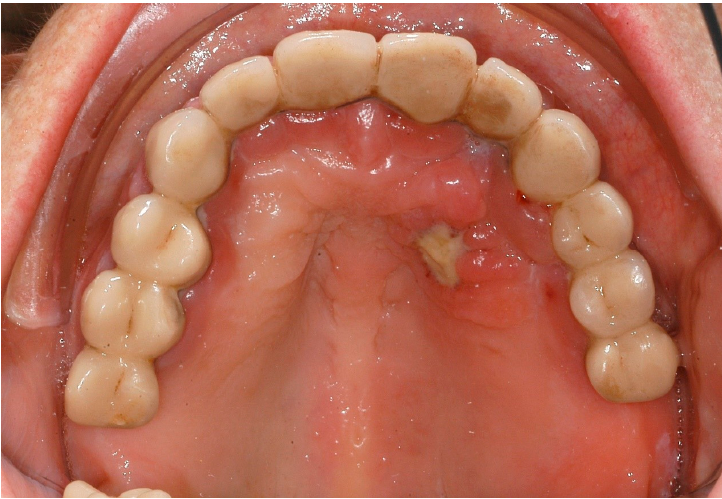
Figure 5. Gingival enlargement and necrosis as a sign of leukaemia in a 75-year-old women.